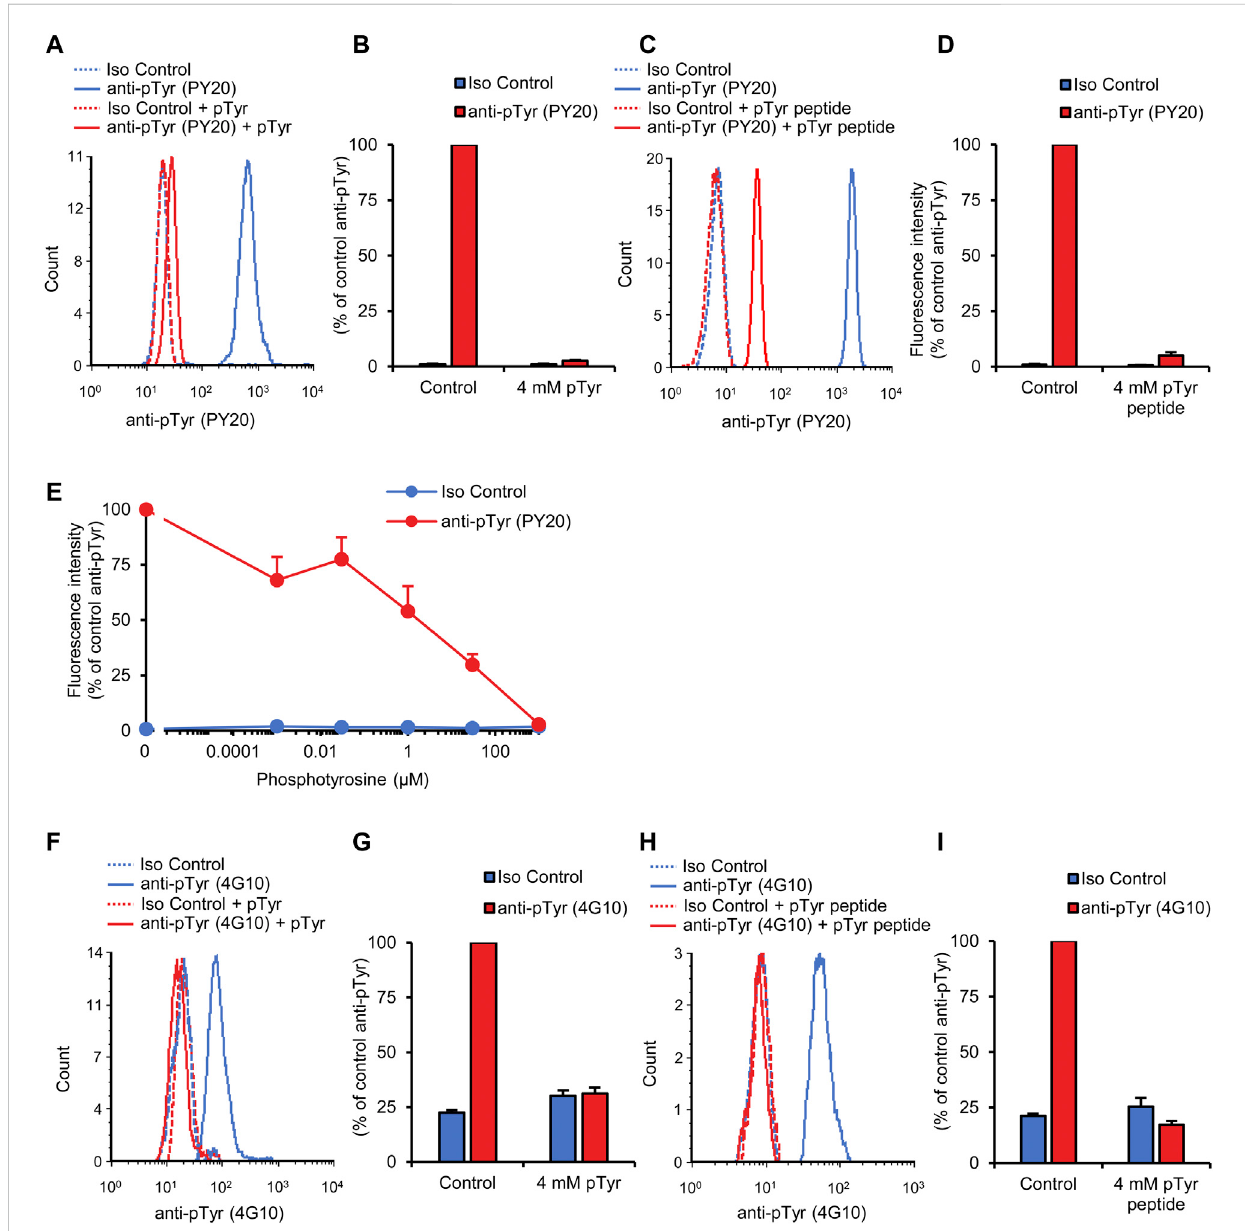
Competition by soluble phosphotyrosine or a tyrosine-phosphorylated peptide. Blood was collected from untreated wild-type mice and stained with the PY20 (A – E) or the 4G10 (F – I) anti-phosphotyrosine antibodies along with isotype controls. Where indicated, the anti-phosphotyrosine antibodies were presaturated with the indicated concentration of soluble phosphotyrosine (A, B, and E – G) or a tyrosine-phosphorylated phosphopeptide (C, D, H, and I) . Representative fl ow cytometric histograms (A, C, F, and H) and geometric mean fl uorescence intensity values normalized to those of samples stained with anti-phosphotyrosine antibodies without any presaturation with their antigens (B, D, E, G, and I) are shown. Quantitative curves and bar graphs show mean and SEM from 17 to 18 (B) , 5 – 6 (D) , 6 – 14 (E) , 24 (G), and 6 (I) mice from 9 (B) , 3 (D) , 7 (E) , 8 (G) , and 4 (I) independent experiments. pTyr, phosphotyrosine; Iso,